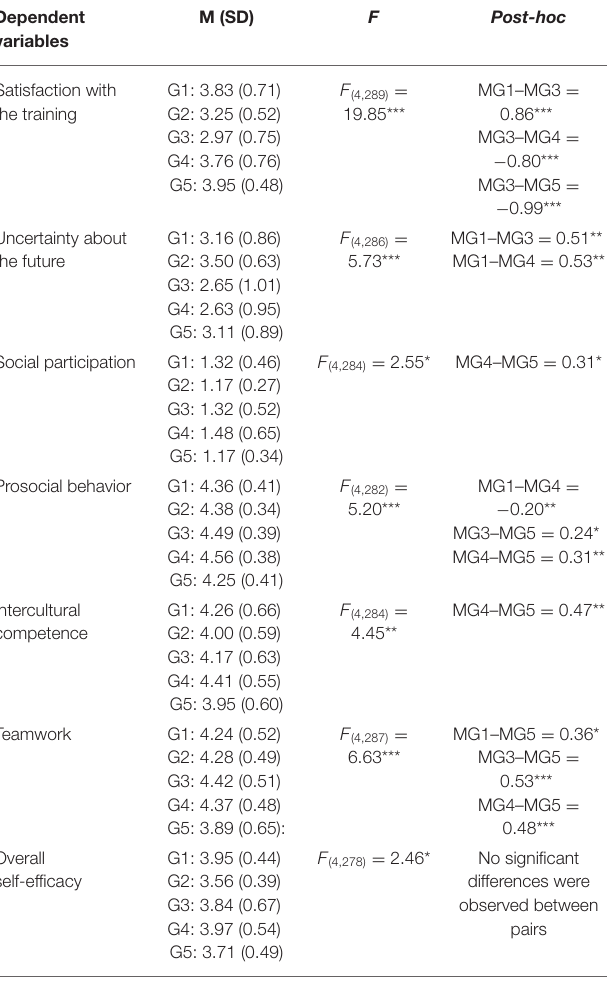
TABLE 6 | One-way ANOVA of all the dependent variables according to the variable “goals of the reflection.” Dependent M (SD) F Post-hoc variables